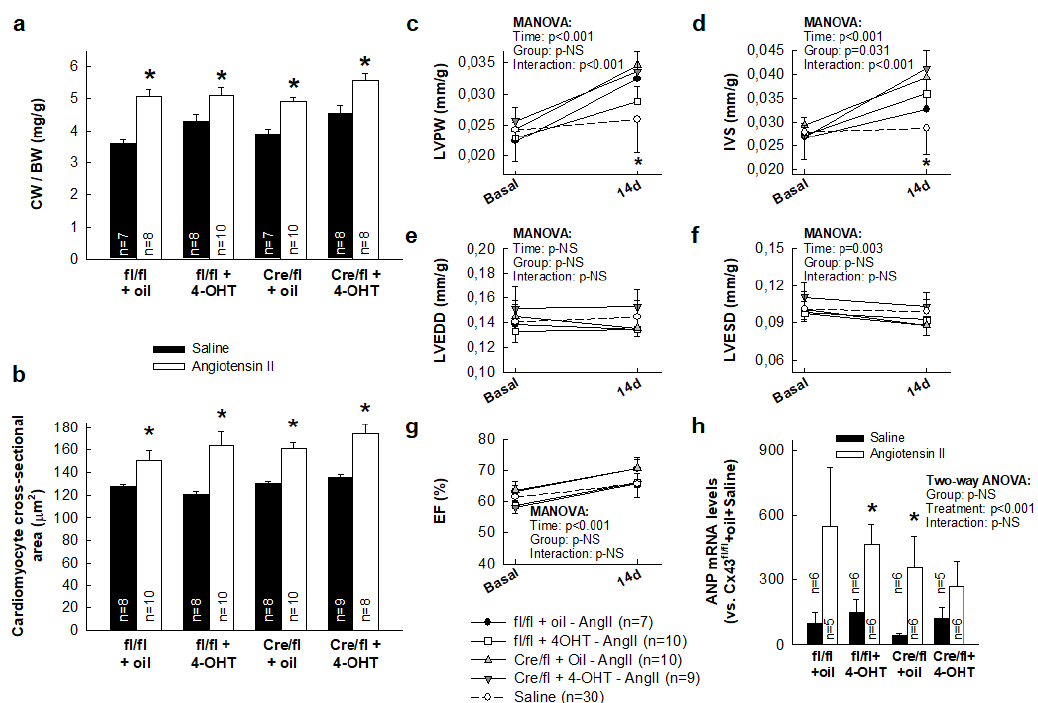
Figure 1. AngII treatment induces a similar cardiac hypertrophic response in hearts from Cx43 fl/fl and Cx43 Cre-ER(T)/fl mice, independently of Cx43 expression levels. Changes in cardiac weight/body weight (CW/BW) ratio ( a ) and cardiomyocyte cross-sectional area ( b ) in Cx43 fl/fl (fl/fl) and Cx43 Cre-ER(T)/fl (Cre/fl) mice, treated with saline or angiotensin II for 14 days. * ( p < 0.05) indicates significant differences vs. the corresponding saline-treated group. ( c – g ) Changes in left ventricular posterior wall thickness (LVPW), interventricular septum thickness (IVS), left ventricular end-diastolic internal diameter (LVEDD), left ventricular end-systolic internal diameter (LVESD) (all expressed vs. body weight), and ejection fraction (EF) in the same animals. Data from saline-treated animals are shown pooled as a single group. * ( p < 0.05) indicates significant differences vs. all groups except Cx43 fl/fl +4-OHT + AngII and Cx43 fl/fl + oil + AngII in C and D, respectively. ( h ) Changes in myocardial ANP mRNA. * ( p < 0.05) indicates significant differences vs. the corresponding saline-treated group.